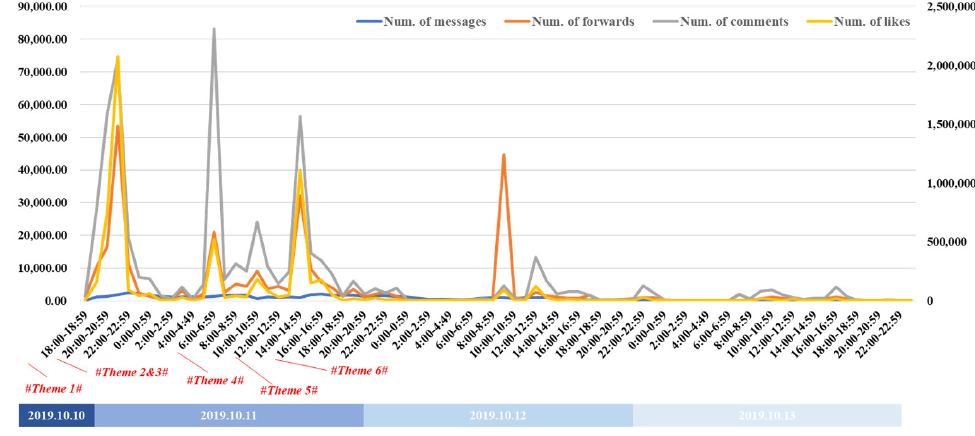
Figure 5. Number of messages/forwards/comments/likes related to the accident.